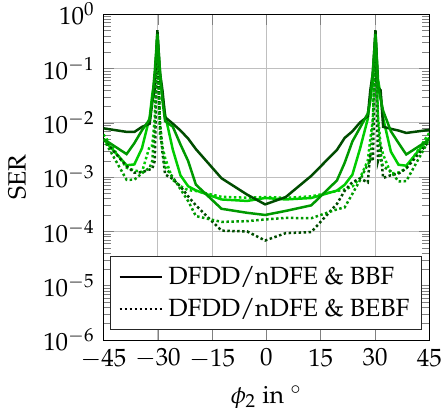
Figure 8. Symbol error rate vs. angle φ 2 of user 2 at different spatial spread σ s considering the full-array architecture: σ s = 2 ◦ ( ), σ s = 4 ◦ ( ), σ s = 8 ◦ (